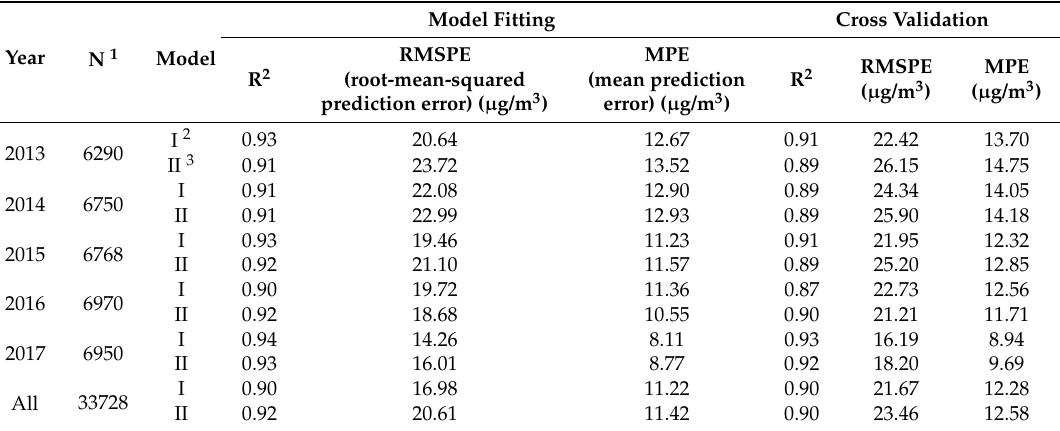
Table 1. Model performance summary for MAIAC AOT.